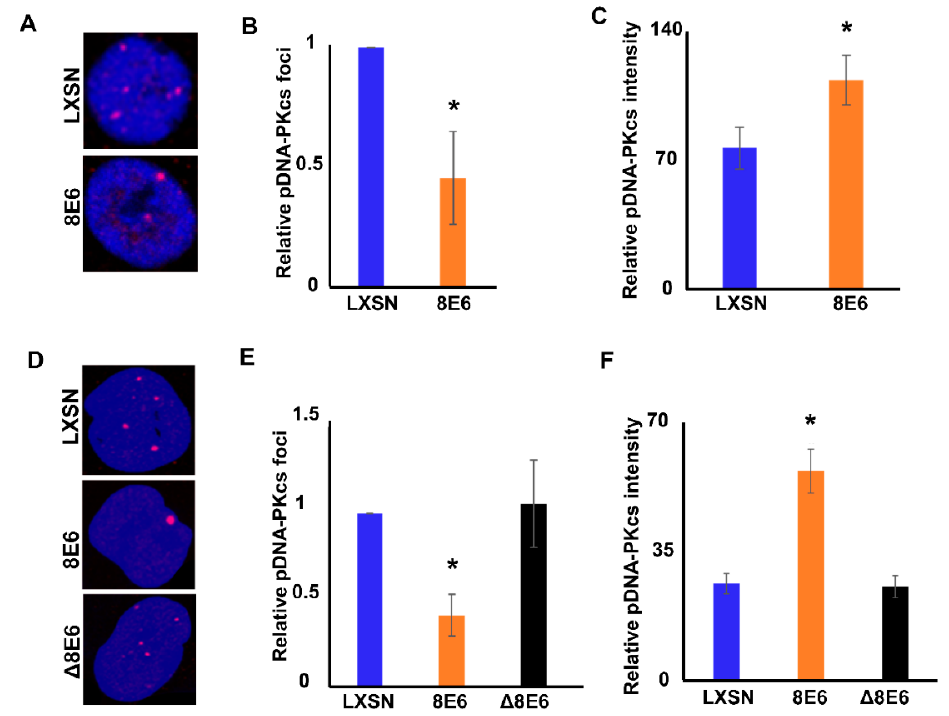
Figure 3. β -HPV 8E6 increases pDNA-PKcs foci size, but decreases frequency in untreated cells. ( A ) Representative images of pDNA-PKcs foci in HFK LXSN and HFK β -HPV 8 E6. ( B ) Percentages of cells with one or more pDNA-PKcs foci. ( C ) Average pDNA-PKcs foci intensity of HFK cells. ( D ) Representative images of pDNA-PKcs foci in U2OS LXSN, U2OS β -HPV 8 E6, and U2OS β -HPV ∆ 8 E6. ( E ) Percentages of cells with one or more pDNA-PKcs foci. ( F ) Average pDNA-PKcs focus intensity in U2OS cells. All values are represented as mean ± standard error from at least three independent experiments. Statistical di ff erences between groups were measured by using Student’s t -test. * indicates p < 0.05. All microscopy images are 400X magnification.